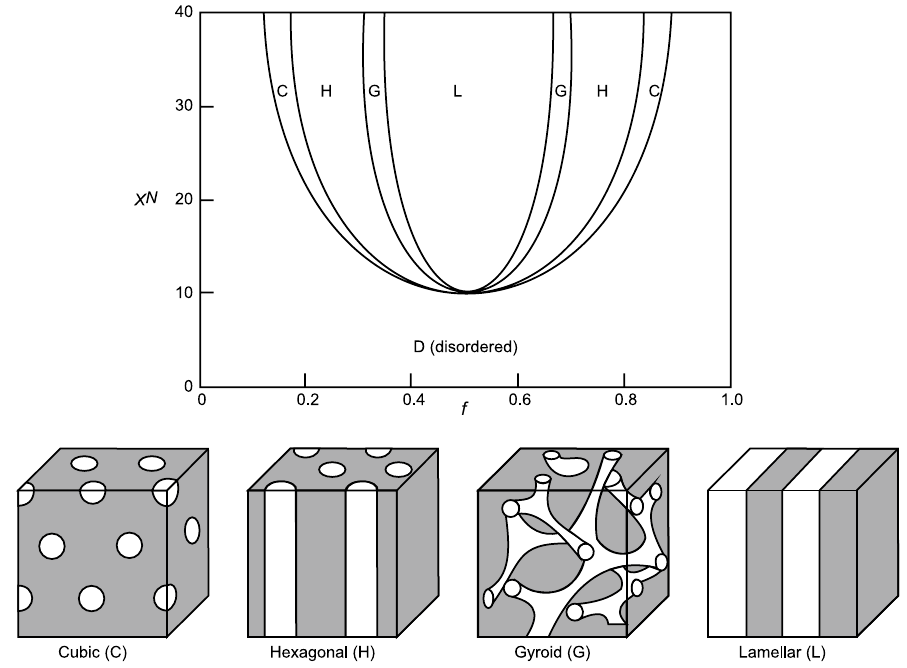
Figure 1. (Top) Phase diagram of a diblock polymer. The horizontal axis is the fraction of a monomer f , while the vertical axis shows χ N , the product of the polymerization N and the interaction parameter χ . (Bottom) Schematics of the phases of a diblock